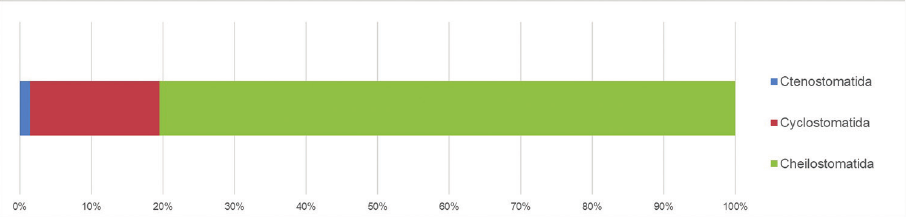
Figure 8. Taxonomic coverage (reported in percentage of specimens per order) of the MNA Bryozoa collection. Cheilostomatida cover the vast majority of the collection (~80% of the collection specimens), followed by Cyclostomatida (~18%) and Ctenostomatida (~2%).